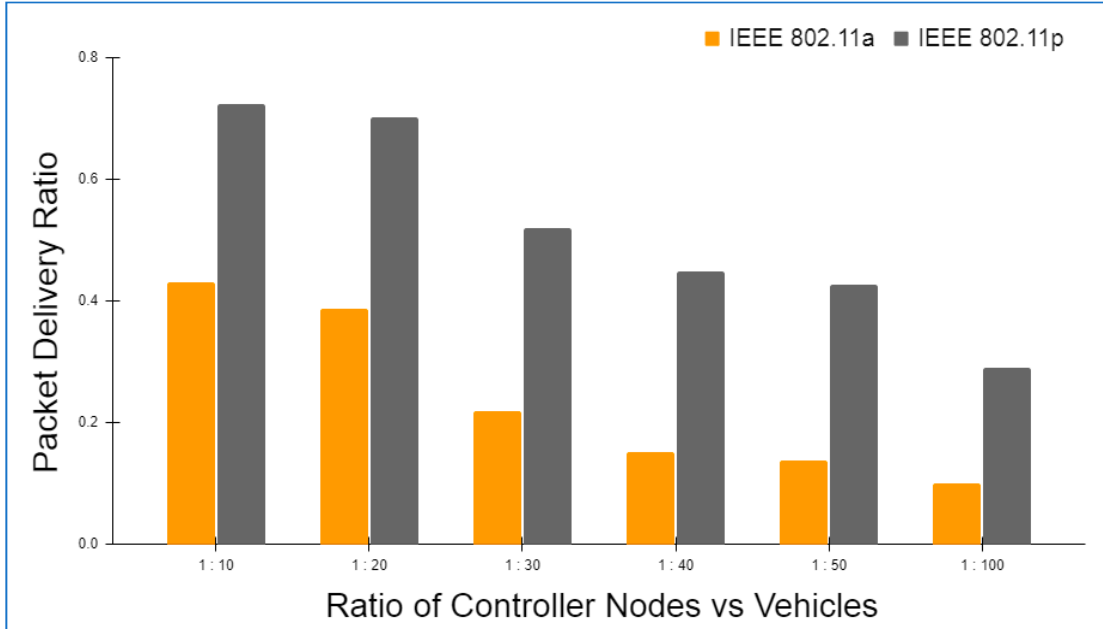
Figure 11. Packet Delivery Ratio in the proposed framework for IEEE 802.11a vs. IEEE802.11p.